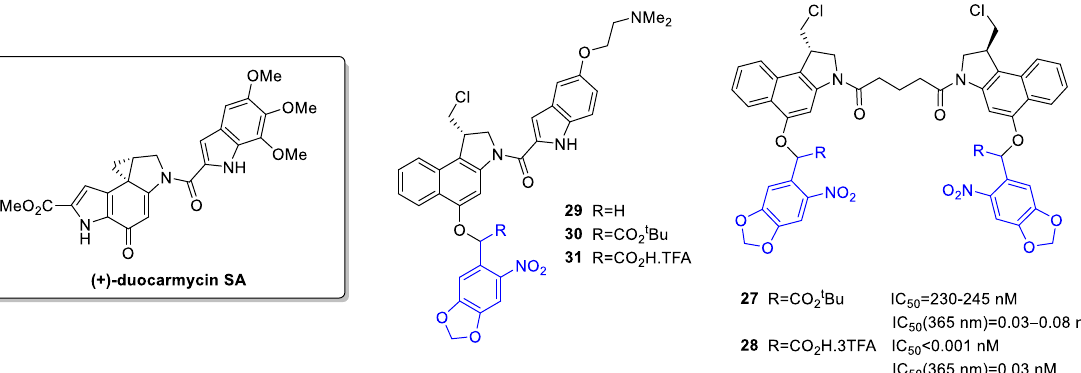
Figure 6. Photocaged duocarmycin derivatives, the PPG indicated in blue.